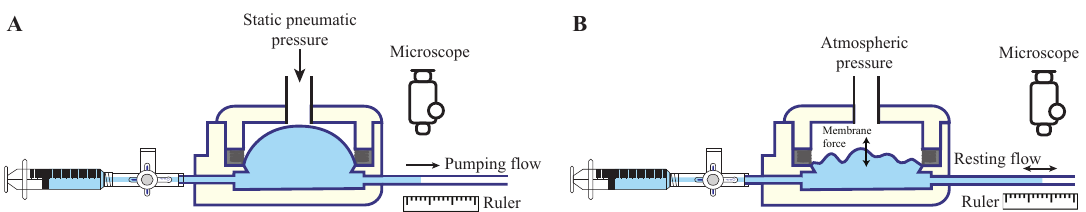
Figure 4. Benchtop test setup for the storing membrane characterization. ( A ) The microreservoir was filled, and the inlet was blocked using the stopcock. The fluid in the storing membrane was pumped via a static pneumatic pressure on the membrane until 20% of the capacity was discharged. ( B ) The pneumatic pressure was released, and the flow in the tubing due to membrane force was quantified under a microscope. Di ff erent tubing sizes were used for the three capacities to maintain a minimum resolution of 0.1% of the full capacity. The experiment was repeated for the next 20% of the overall capacity. The total discharged fluid after the fifth step indicates the total extraction